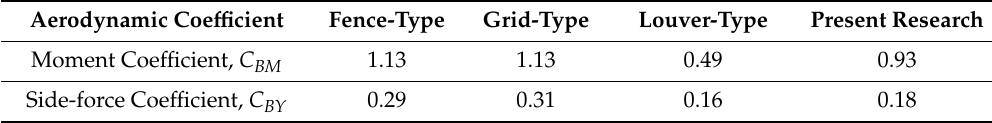
Table 1. Aerodynamic coe ffi cients of the bridge with di ff erent types of wind